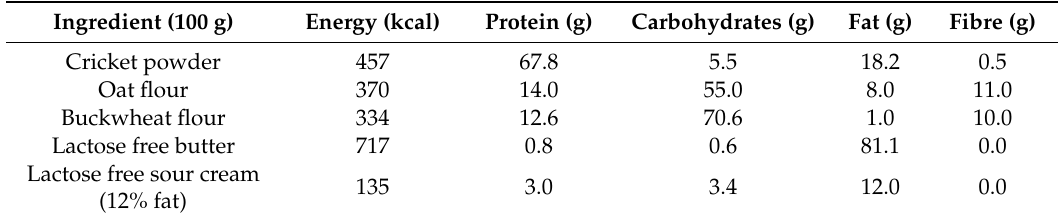
Table 2. The energy value, macronutrient, and fibre composition of the used ingredients. Only the quantitatively relevant ingredients are listed. The nutritional values are given in their density (g or kcal) in 100 g of each